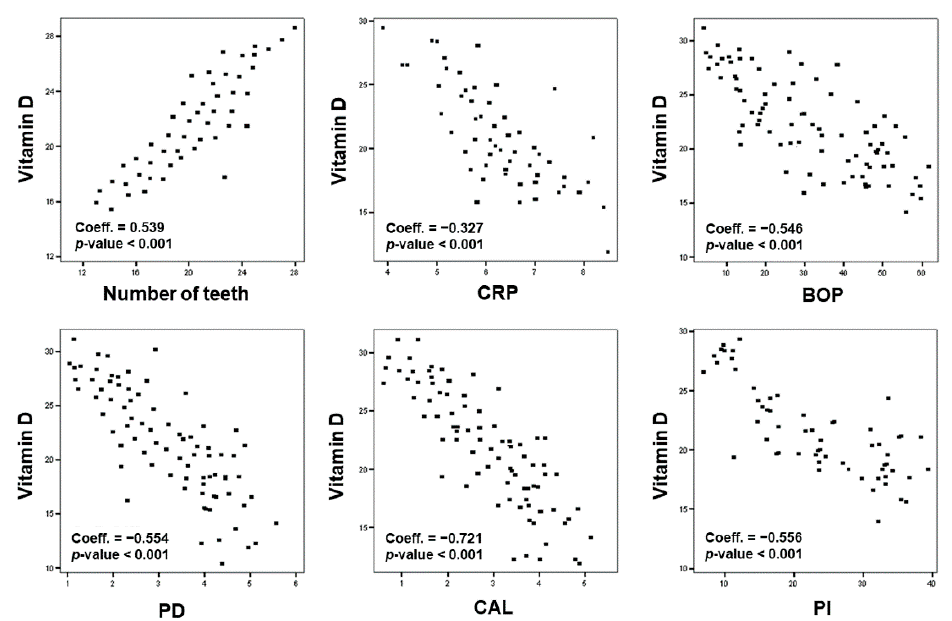
Figure 2. Correlation analysis among vitamin D levels, CRP, and periodontal parameters (Correlation Spearman’s). Coeff., coefficient.